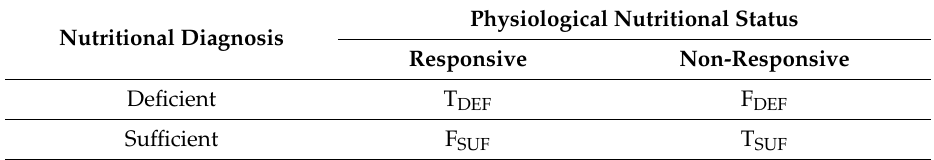
Table 1. Distribution of nutritional diagnosis to assess the nutritional status of Eucalyptus spp. clonal rooted cuttings, using CL, DRIS and CND methods. Physiological Nutritional Status Nutritional Diagnosis Responsive Non-Responsive Deficient T DEF F DEF Su ffi cient F SUF T SUF